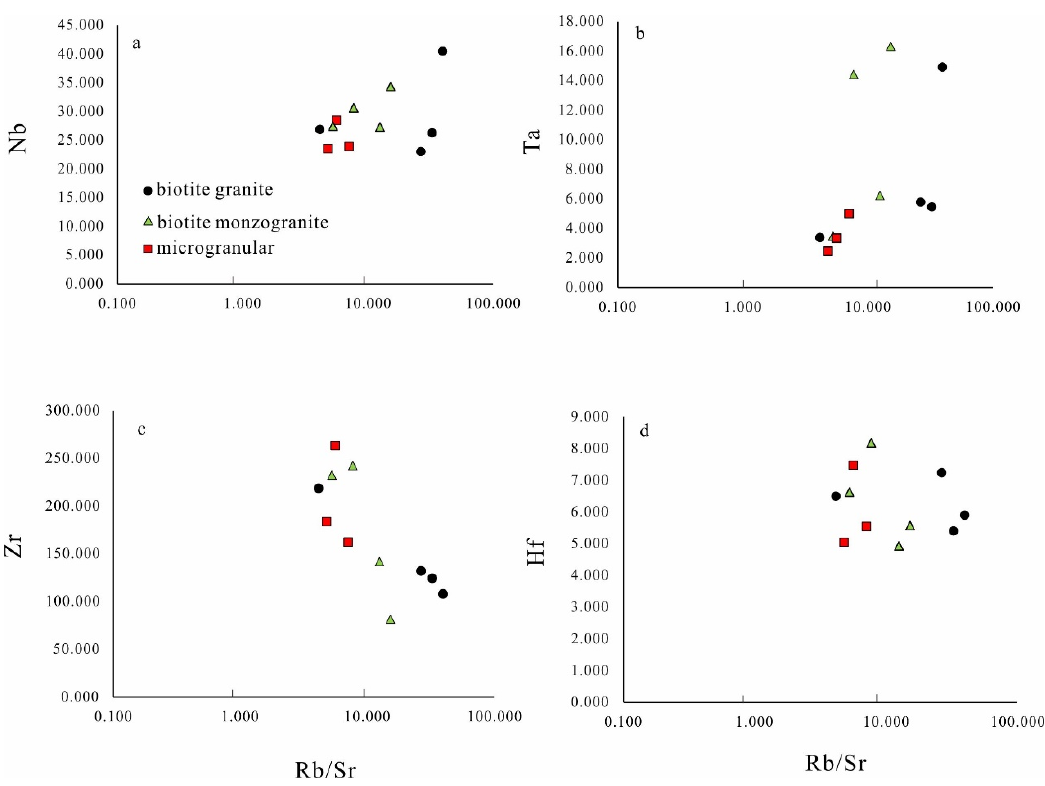
Figure 12. Variations of Rb/Sr versus the concentration of Nb ( a ), Ta ( b ), Zr ( c ), and Hf ( d ) from the Xitian intrusion.